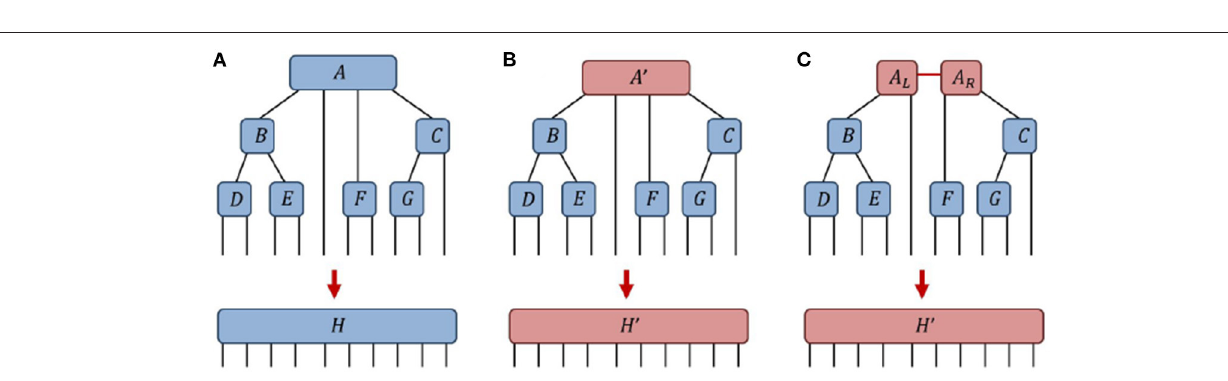
Frontiers in Applied Mathematics and Statistics |